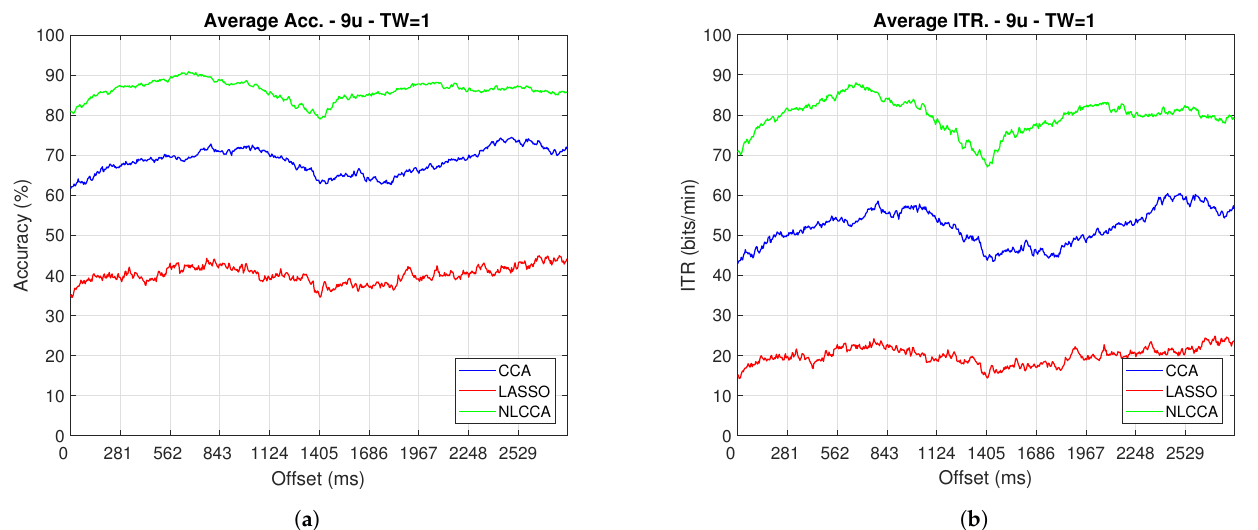
Figure 12. One–second sliding window (trimmed 50 first data–around 200 ms) of ( a ) Accuracy and ( b ) ITR removing User 3. Table 2. Mean and standard deviation of the offset